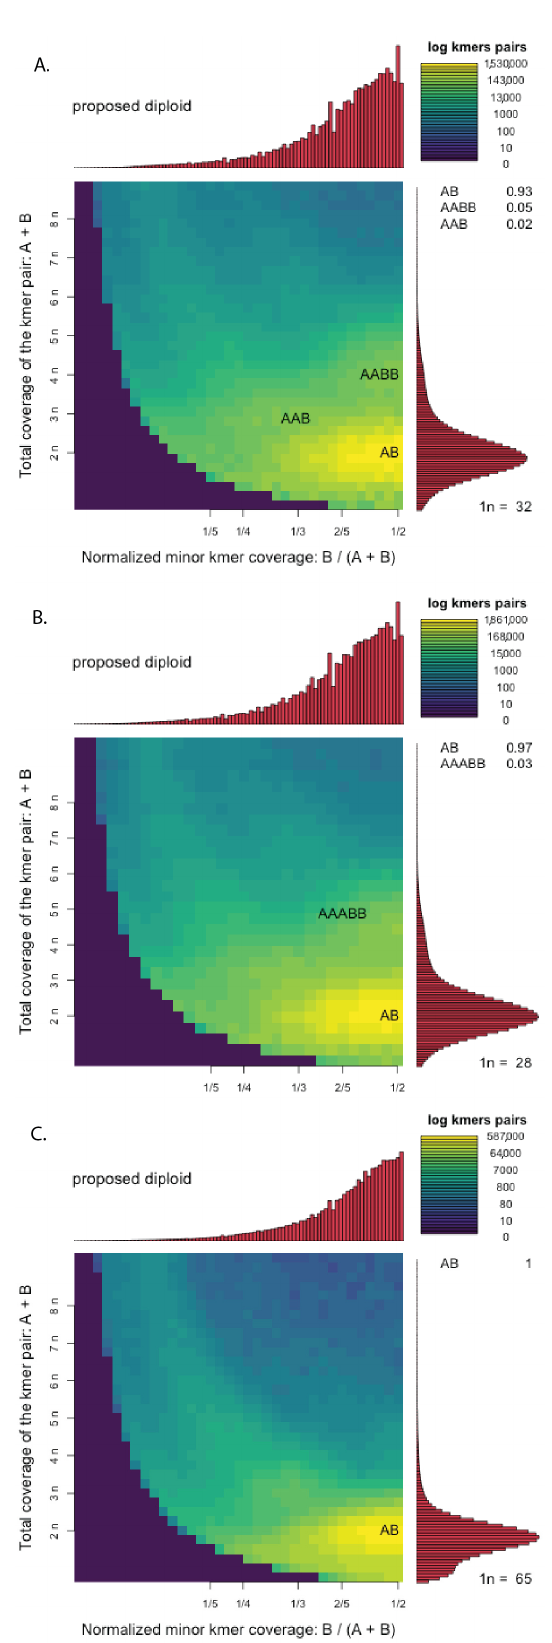
Figure 4. Smudgeplot output for ( A ) MEX13, ( B ) MEX26, and ( C ) MEX67. The color intensity of the smudge indicates how frequently the haplotype structure is represented within each genome and the bar plots represent sequencing